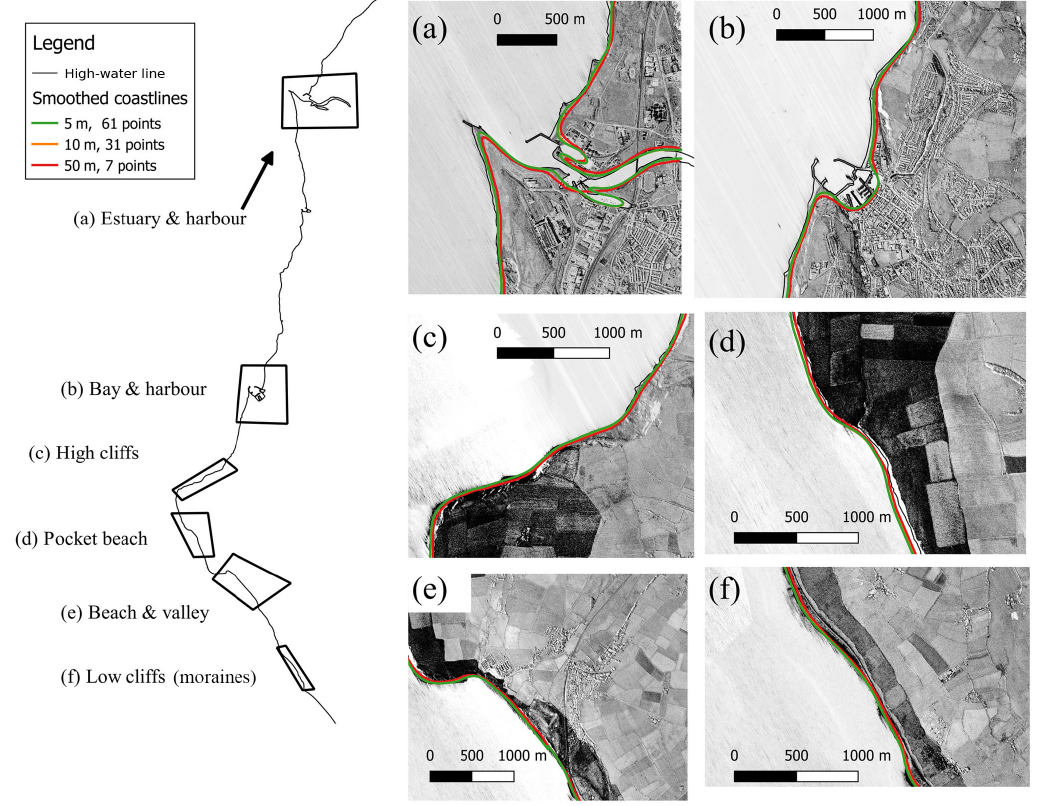
Figure 6. Location of six different coastal morphologies around St Bees Heritage Coast and smoothed coastline obtained for different DEM resolutions and window sizes used for smoothing. Original radar images used to build the NEXTMap DEM shown in grey scale. Smoothed line for the 10m DEM with 31 points window size (orange line) is almost identical to the line obtained for the 5m DEM with 61 points window size (green line) and not always